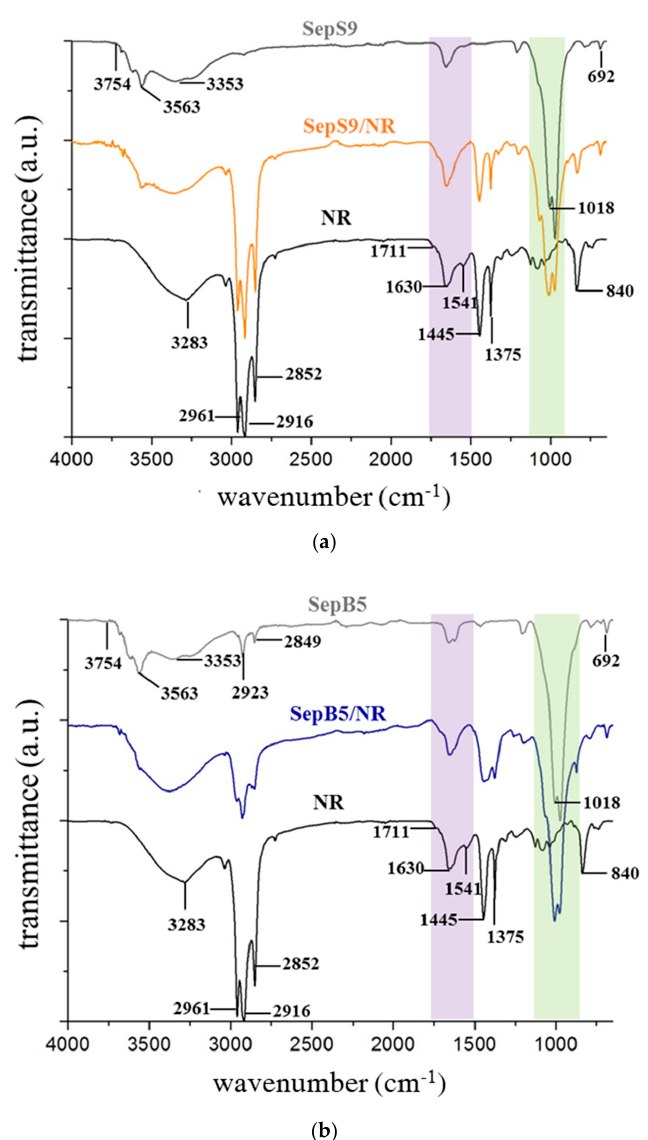
Figure 3. Fourier transform infrared spectroscopy (FTIR) spectra of ( a ) NR (black line), SepS9 (gray line), SepS9/NR biocomposite (orange line), ( b ) NR (black line), SepB5 (gray line), SepB5/NR biocomposite (blue line). The light green and violet shadow areas highlight the most significant spectral regions.